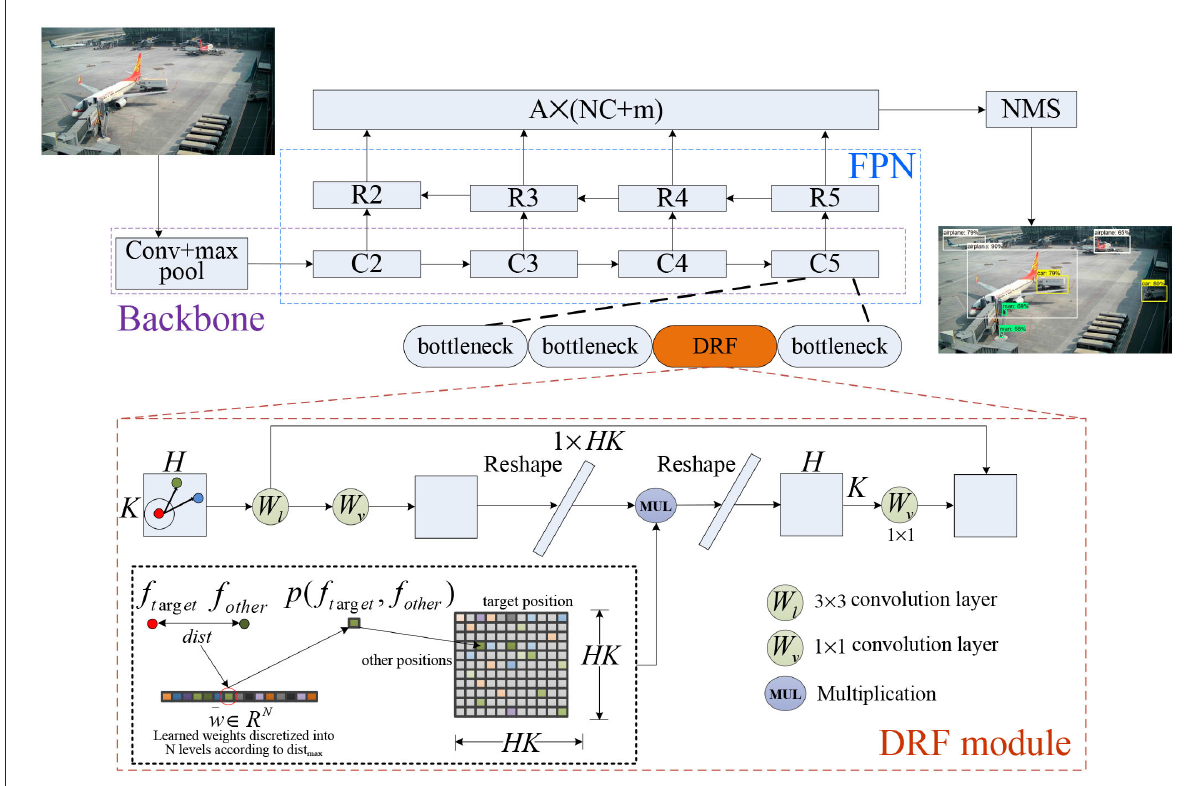
FIGURE2 The structure of network built on our proposed DRF module for object